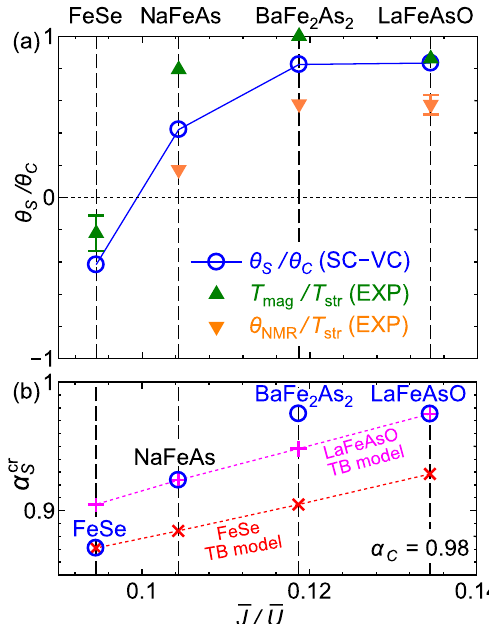
= θ FIG. 5. (a) θ obtained for four theoretical models. S C =T =T Experimental values of T and θ are also shown. mag str NMR str θ is the Weiss temperature of 1 =T 1 T obtained by the Curie- NMR Weiss fitting for T > T in LaFeAsO [60], BaFe 2 As 2 [61], and str ≈ 95 K from the NaFeAs [62]. In LaFeAsO, we derived θ NMR Curie-Weiss fitting of 1 =T 1 T above T . In FeSe, we derived str − 10 ∼ − 30 K from the Curie-Weiss fitting of 1 =T T mag ¼ below T [2]. Thus, theoretically expected relationships str θ ≲ θ ≳ θ =T = θ =T = θ and T are verified. (b) α cr S C S C NMR str mag str 0 . 98 . We also plot obtained for four theoretical models at α C ¼ α cr for the hybrid models: H 0 (LaFeAsO TB model) þ rH U S M LaFeAsO and H 0 (FeSe TB þ rH U M FeSe